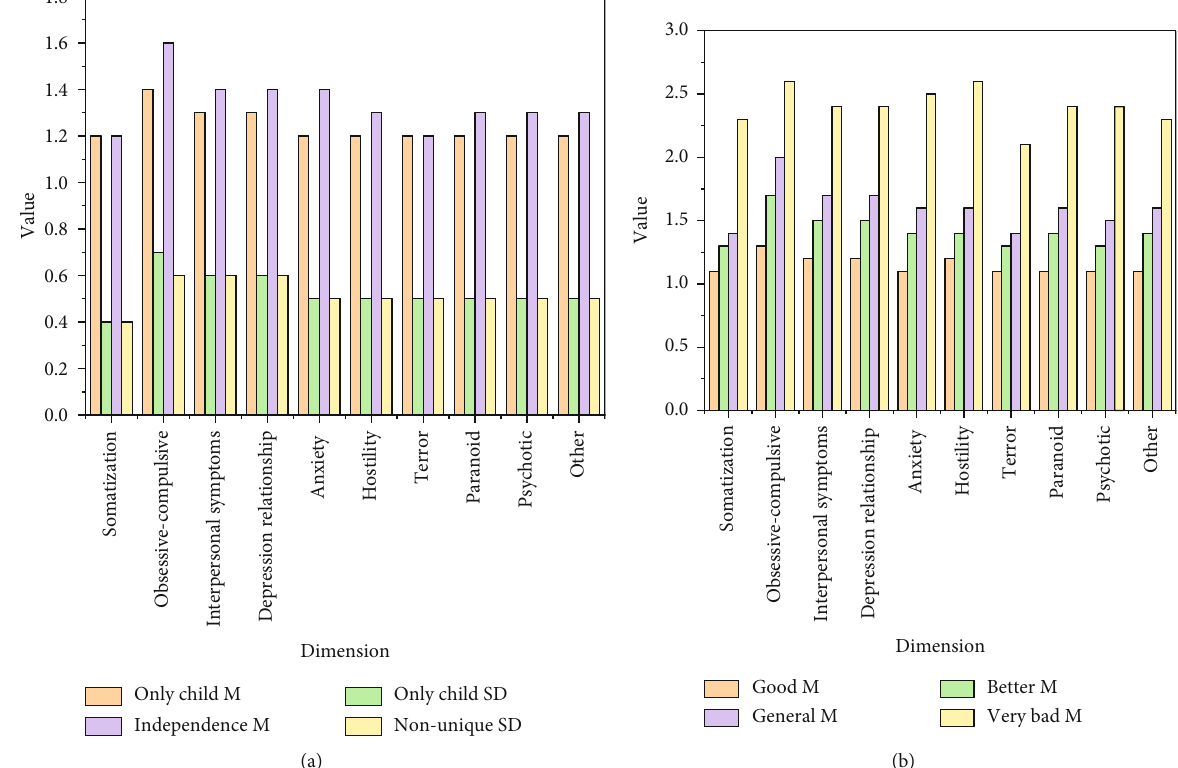
Figure 7: The result chart of the di ff erence between the only child or not and self-evaluation scale on self-condition ((a) whether the only child or not; (b) self-condition di ff erence).